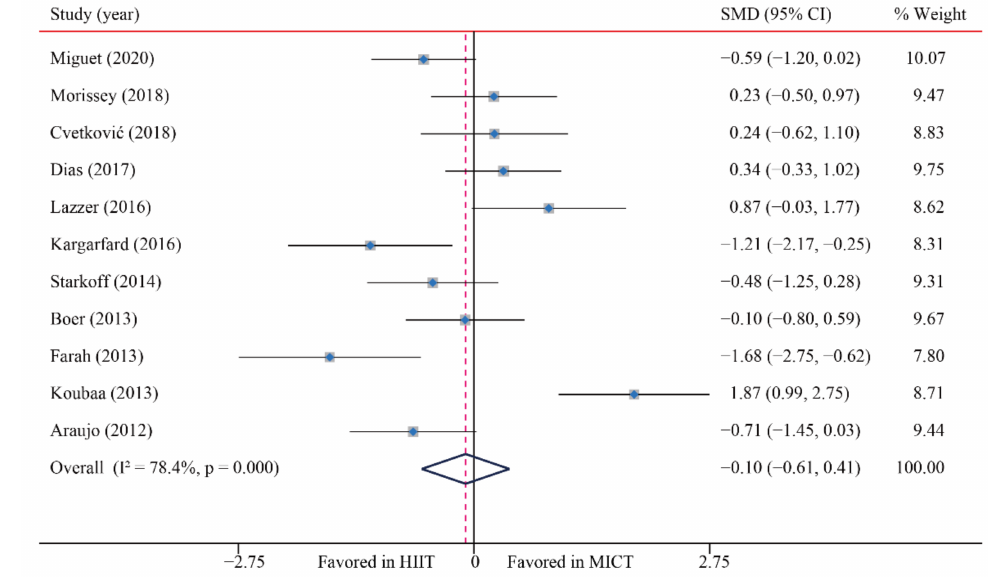
Figure 2. Effect of HIIT versus MICT on body mass. SMD: Standardized mean difference, CI: Confi- dence interval.